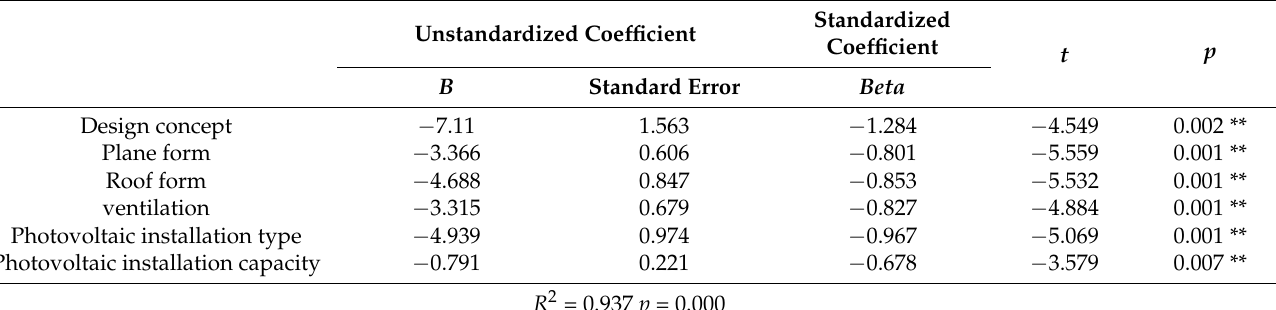
Table 13. Linear regression analysis with architecture contest scores as dependent variable and 6 related factors as independent